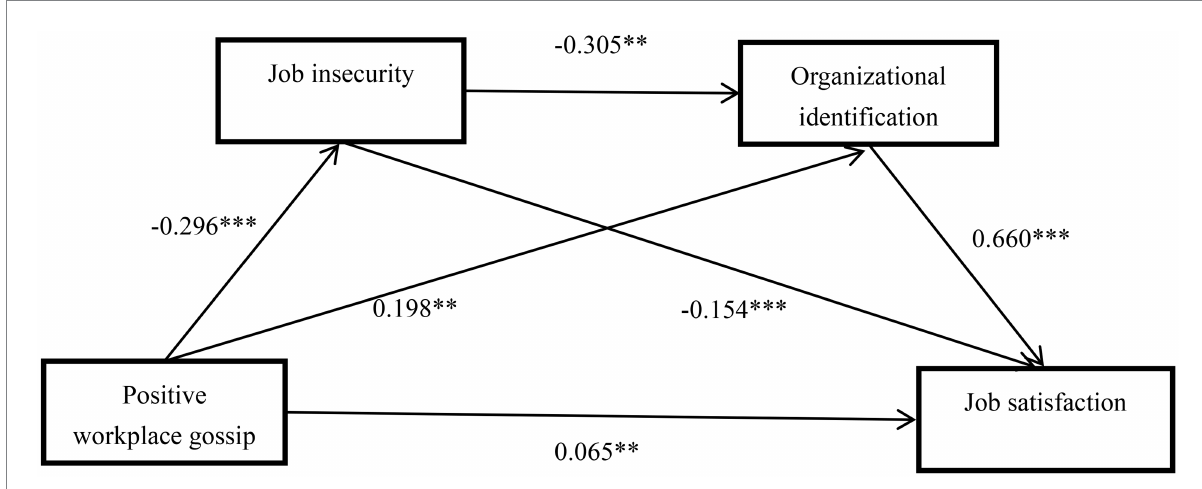
FIGURE 2 Serial mediating model of positive workplace gossip and job satisfaction. ** p < 0.01; *** p <